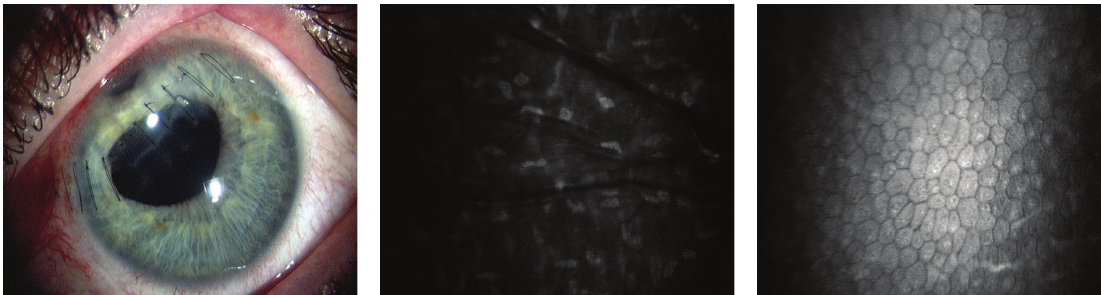
Figure 7: Corneal laceration, traumatic cataract with anterior capsule disruption status after laceration repair, and cataract extraction with intraocular lens